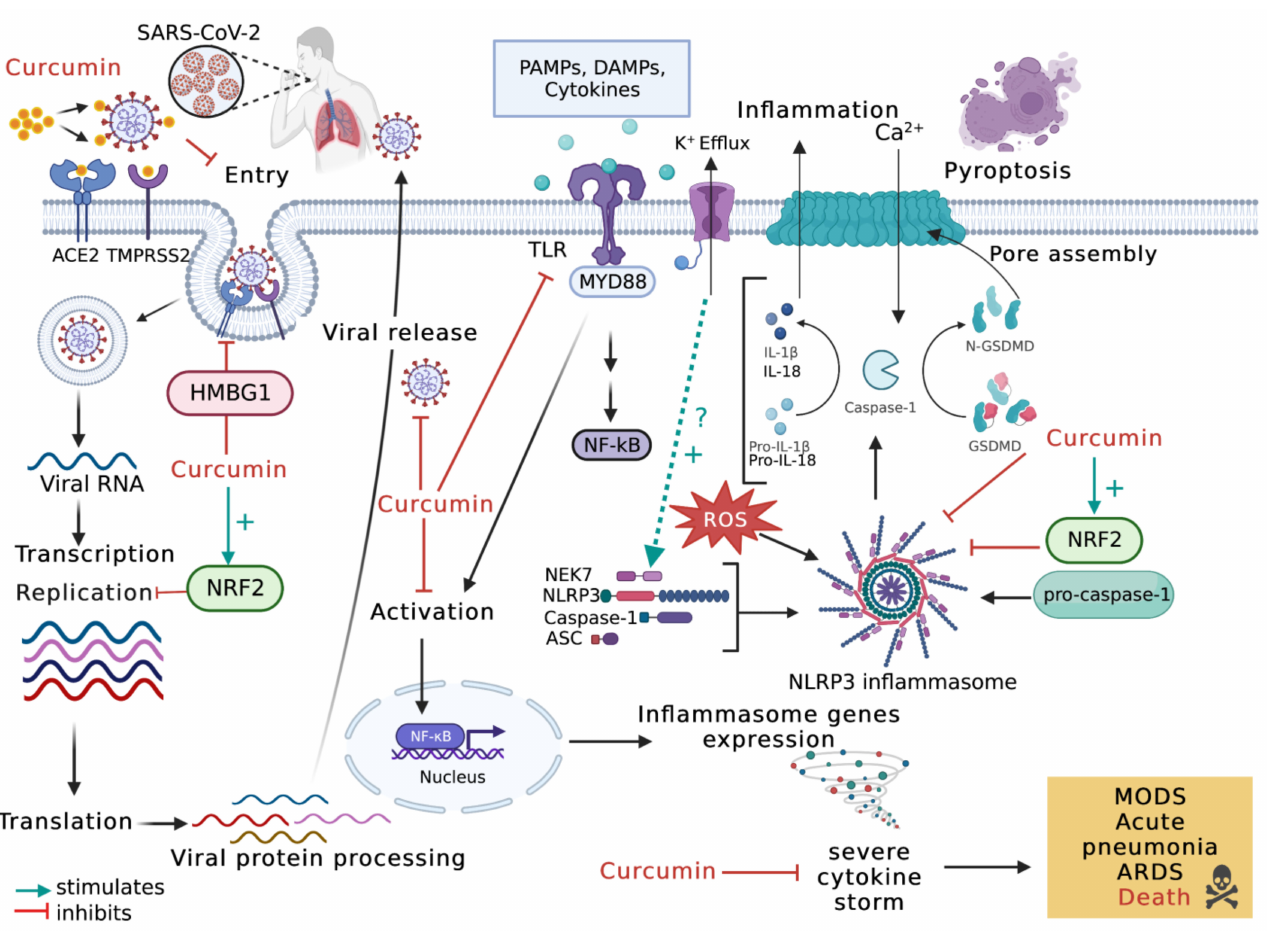
Figure 2. Potential inflammasome-related mechanisms by which curcumin is effective against COVID-19. Inflammasome activation is mediated by potassium ion efflux and by NEK7 and NLRP3 oligomerization The antiviral effect of curcumin against SARS-CoV-2 starts by preventing its entry. Curcumin inhibits NF- κ B via the inhibition of different pathways. The binding of DAMPs, PAMPs, and cytokines to TLR leads to its activation and NF- κ B translocation to the nucleus, which results in the expression of inflammasome genes. NF- κ B activation induces the formation of a protein complex known as the inflammasome, which can lead to cell death through pyroptosis, a pathway to cell death mediated by the activation of caspase-1. However, curcumin can inhibit inflammasome formation by the inhibition of NF- κ B. Curcumin acts as a potential inhibitor of NF- κ B pathway activation. Curcumin induces antiviral responses by positively regulating NFR2 and negatively regulating HMGB1. Following SARS-CoV-2 infection, curcumin modulates responses by inhibiting cytokine responses and oxidative stress, which prevents the progression towards ARDS, acute pneumonia, MODS, and even death. TMPRSS2, transmembrane protease; PAMPs, pathogen-associated molecular pattern; DAMPs, damage-associated molecular patterns; NF- κ B, nuclear factor kappa B; ACE2, angiotensin-converting enzyme 2; HMBG1: High mobility group box 1; NEK7: NIMA Related Kinase 7. Created with